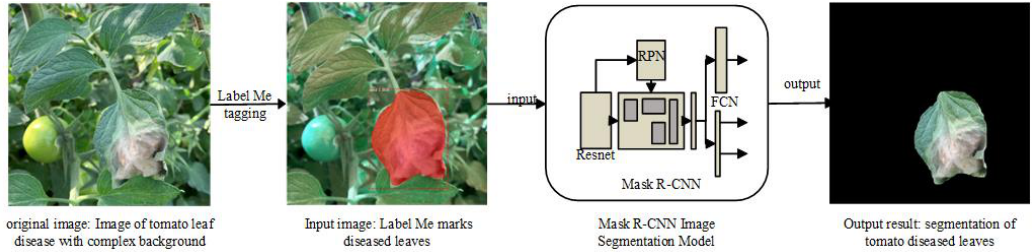
Figure 2. Examples of complex background image processing.